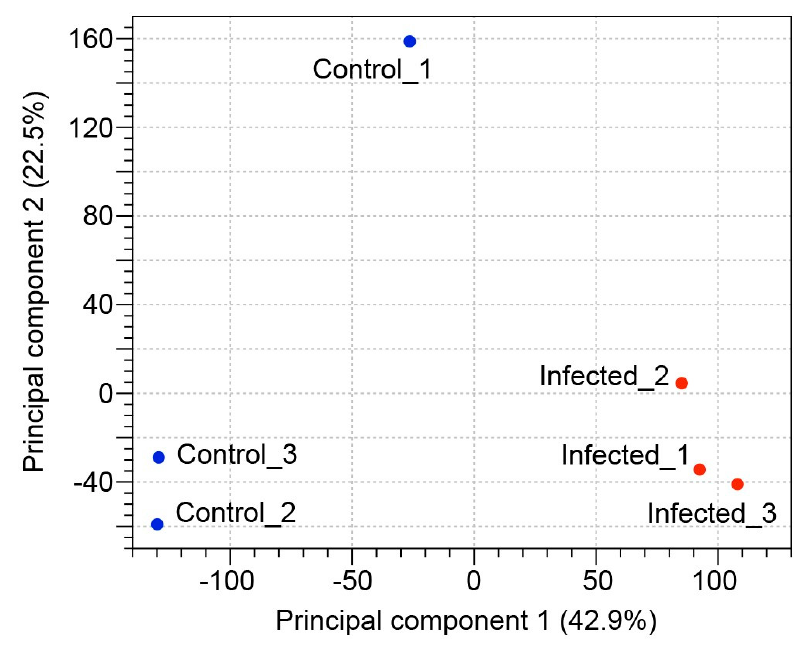
Figure 1. Principal component analysis. PCA plot of normalized RNA-seq expression values of infected and uninfected control replicate zooid samples.